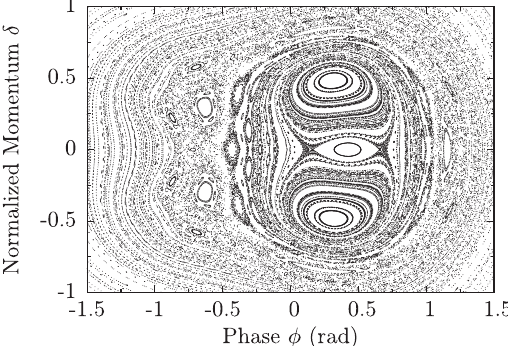
FIG. 14. Nondiffusive Poincaré surface of section depicting the longitudinal phase-space structure with parameters a ν ¼ 2 , and Δ ϕ ¼ 45 °. The resonant islands pertaining to = ν m s o the 2 ∶ 1 resonance can be seen near the primary-rf-only phase- space